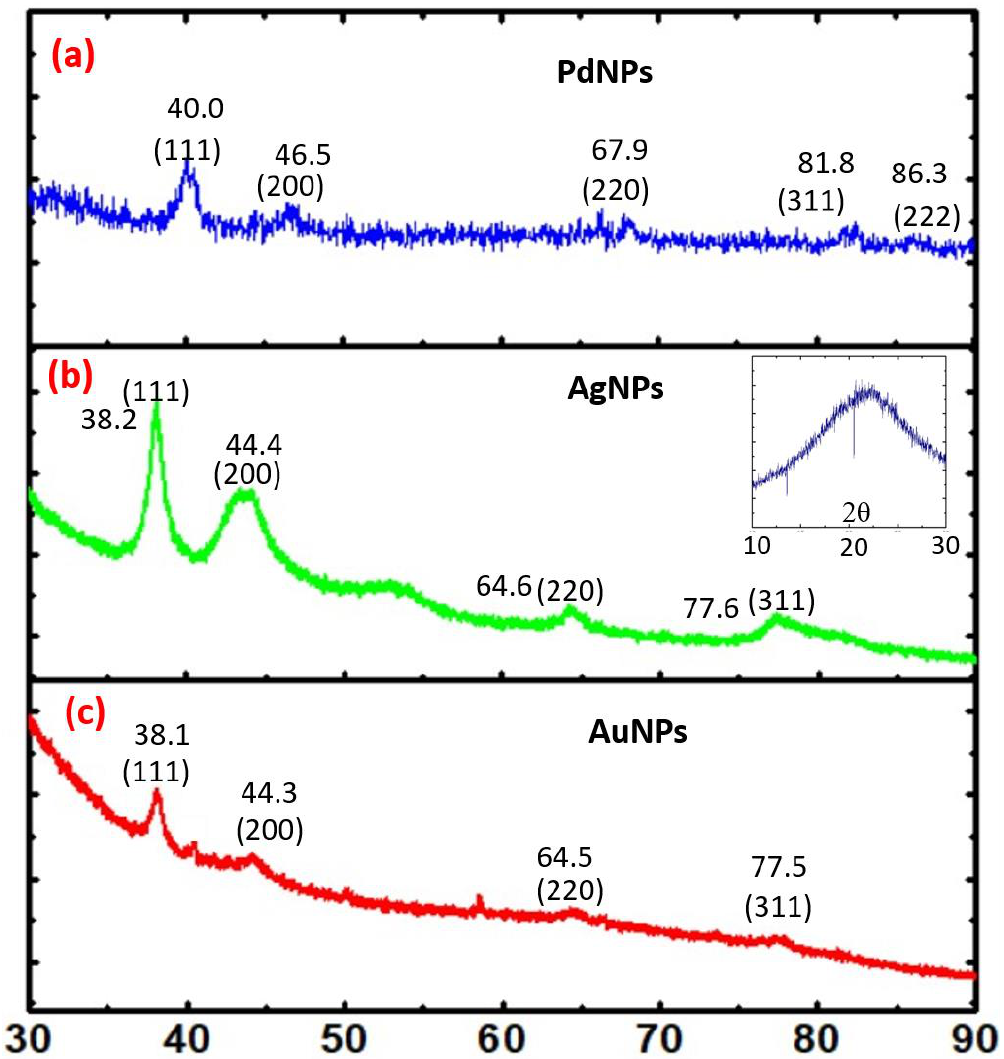
Figure 2. XRD profile of ( a ) PdNPs, ( b ) AgNPs, ( c ) AuNPs.